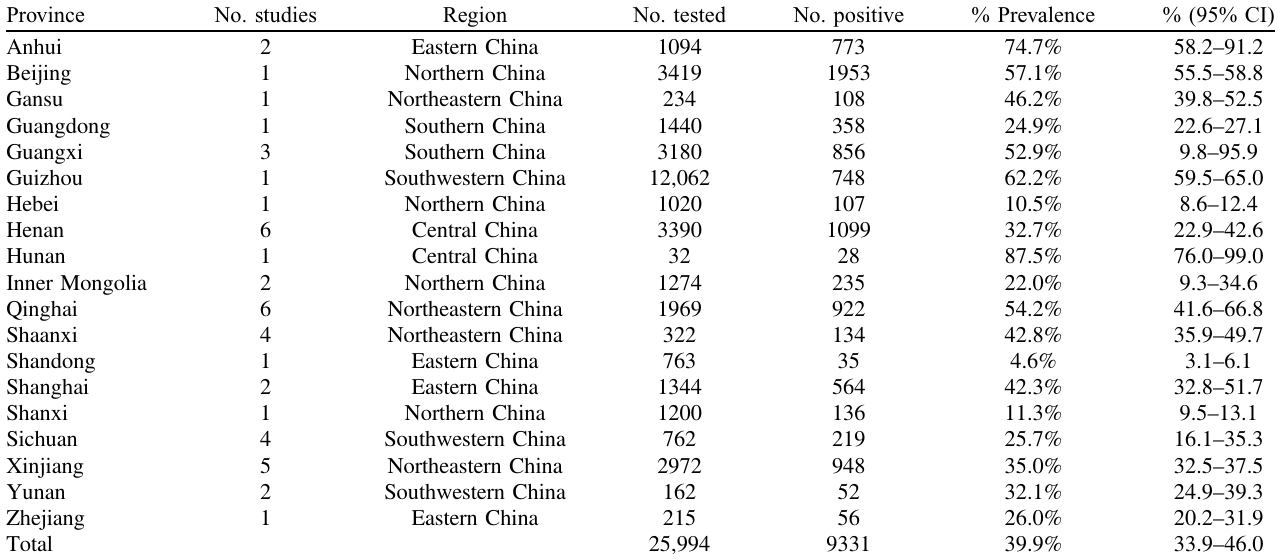
Table 3. Estimated pooled seroprevalence of Eimeria by provincial regions in China. Province